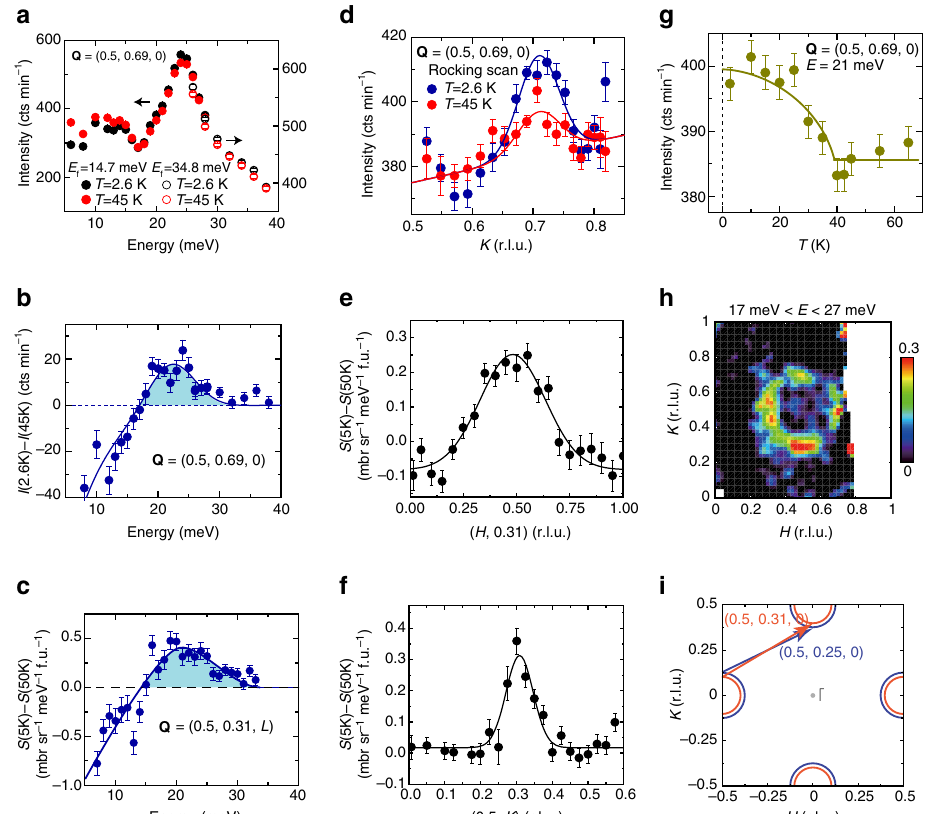
Fig. 1 Magnetic resonant mode in Li 0.8 Fe 0.2 ODFeSe ( T c = 41 K). a Energy dependence of spin excitations for Li 0.8 Fe 0.2 ODFeSe at Q = (0.50, 0.69, 0) in the superconducting state ( T = 2.6 K) and normal state (45 K). The solid and open circles correspond to the data collected at fi nal energies of E f = 14.7 and 34.8 meV, respectively. b Intensity difference between the superconducting state and normal state ( S (2.6 K) – S (45 K)) at (0.50, 0.69, 0) measured on the PUMA thermal triple-axis spectrometer. The data collected at different E f were normalized. c Intensity difference between the superconducting state and normal state ( S (5 K) – S (50 K)) at (0.50, 0.31, L ) measured on the ARCS time of fl ight spectrometer (0.5 ≤ L ≤ 4). d Rocking scan near (0.50, 0.69, 0) at E = 21 meV at T = 2.6 K and 45 K. e , f Intensity difference between the superconducting state and normal state ( S (5 K) – S (50 K)) along the ( H , 0.31) and (0.50, K ) directions. g Temperature dependence of the scattering at (0.50, 0.69, 0) and E = 21 meV. h Intensity difference image ( S (5 K) – S (50 K)) at E = 22 ± 5 meV. The color bar indicates scattering intensity in unit of mbr sr − 1 meV − 1 f. u. − 1 . The white regions in the color plot are gaps between neutron detectors. i Schematic of the electron Fermi pockets in Li 0.8 Fe 0.2 ODFeSe ( red ) and (Tl,Rb) x Fe 2 − y Se 2 ( blue ) adapted from ref. 9 . The calculated resonance wavevector is approximately (0.50, 0.3125) for 0.1 electrons per Fe 14 , which is consistent with our data (0.50, 0.31). The error bars indicate one